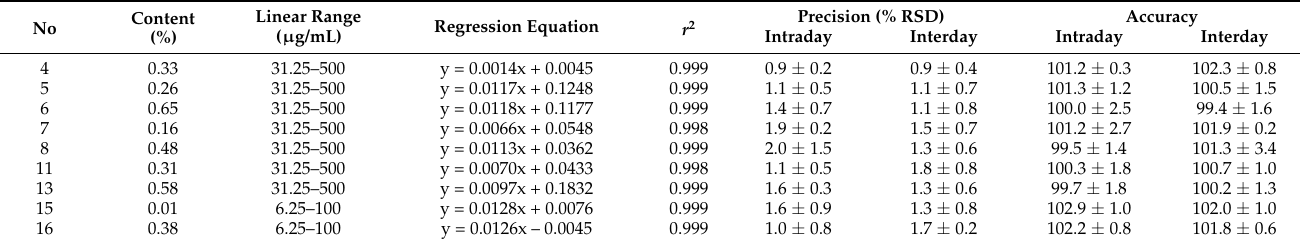
Table 2. Quantitative analysis of nine compounds of the persimmon leaves